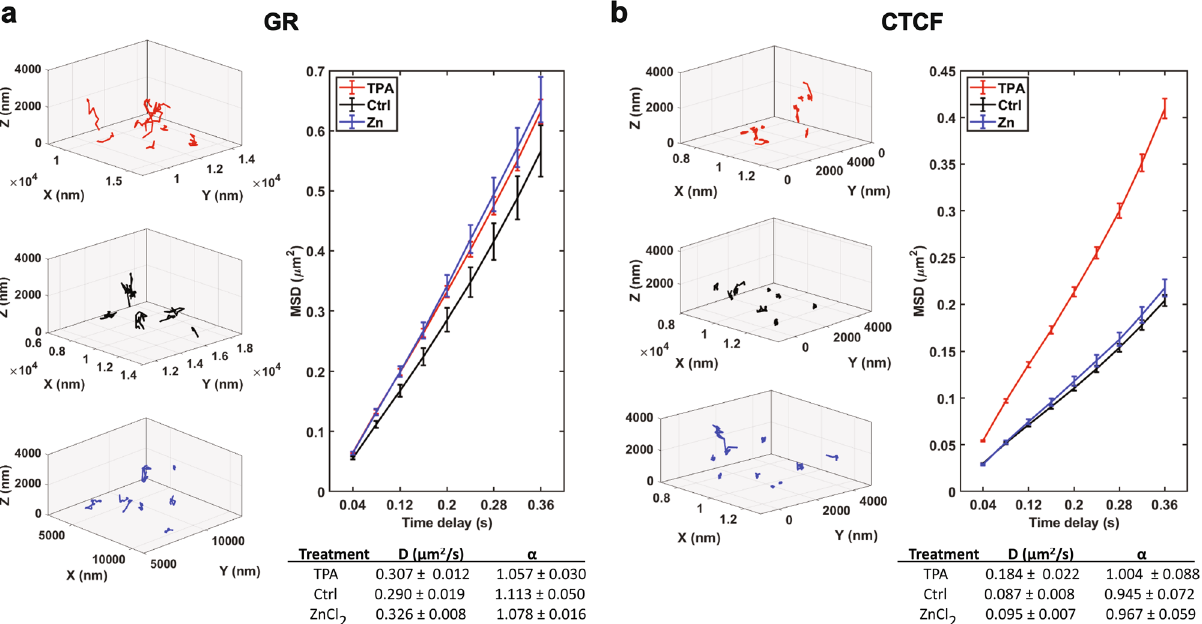
Figure 2. Dynamics of HaloTag-GR and HaloTag-CTCF upon perturbation of Zn 2+ , as measured by MFM. ( a ) Left, representative 3D SM trajectories for cells expressing HaloTag-GR treated with 50 µM TPA (red, top), a media-only control (black, middle), or 30 µM ZnCl 2 (blue, bottom). Note that the volumes displayed for each treatment are equal, although the relative trajectory positions differ between conditions. Right, averaged mean squared displacement (MSD) curves as a function of time for each treatment, with the 95% confidence intervals for each time delay shown. Below, the calculated diffusion coefficients (µm 2 /s) and α values extracted from each curve are shown with 95% confidence intervals. ( b ) Same as in ( a ), but for cells expressing